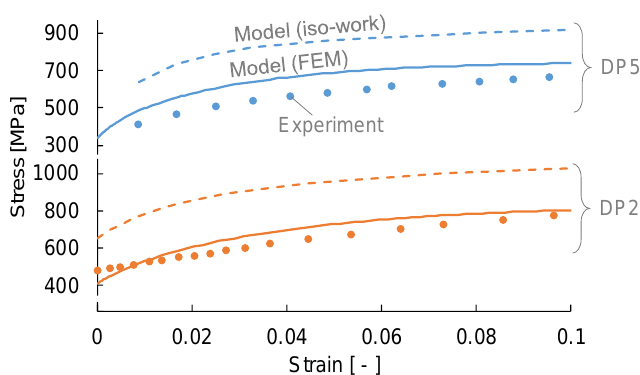
Figure 15. Comparison of stress–strain curve prediction between iso-work and FEM in DP5 and